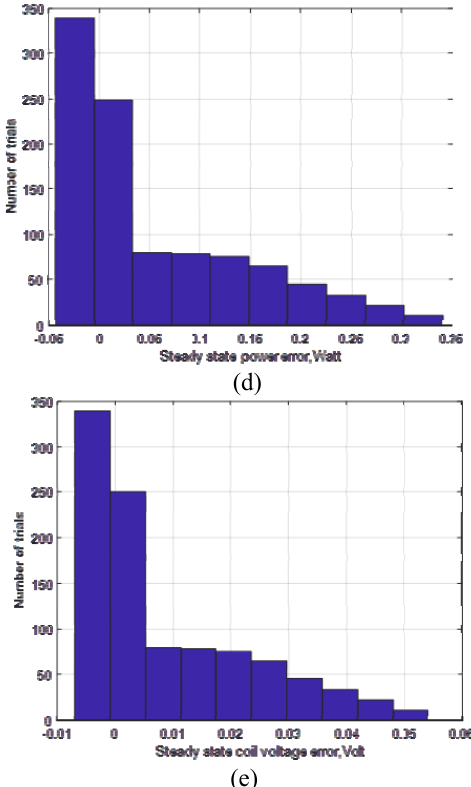
Figure 9. Histograms of steady-state errors from 1000 Monte-Carlo trials; (a) ball position errors; (b) ball velocity errors; (c) coil current errors; (d) coil voltage errors; (e) electrical power errors